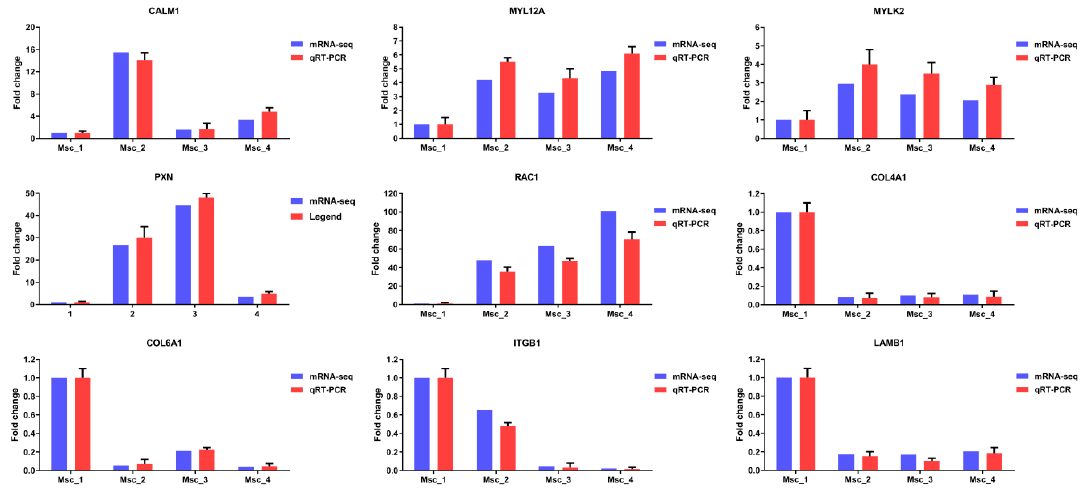
Figure 7. qRT-PCR validation of mRNA-seq data. The expression levels of nine differentially expressed genes (CALM1, COL4A1, COL6A1, ITGB1, LAMB1, RAC1, MYL12A, MYLK2, and PXN) were normalized against GAPDH. The vertical axis indicates the normalized genes expression level for each stage. For each gene, the expression level and sequencing abundance in Msc_1 were given as a negative control and set at 1.